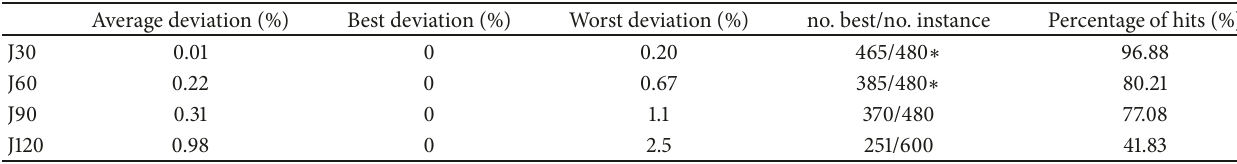
Table 2: Experimental results by PMPSO on each